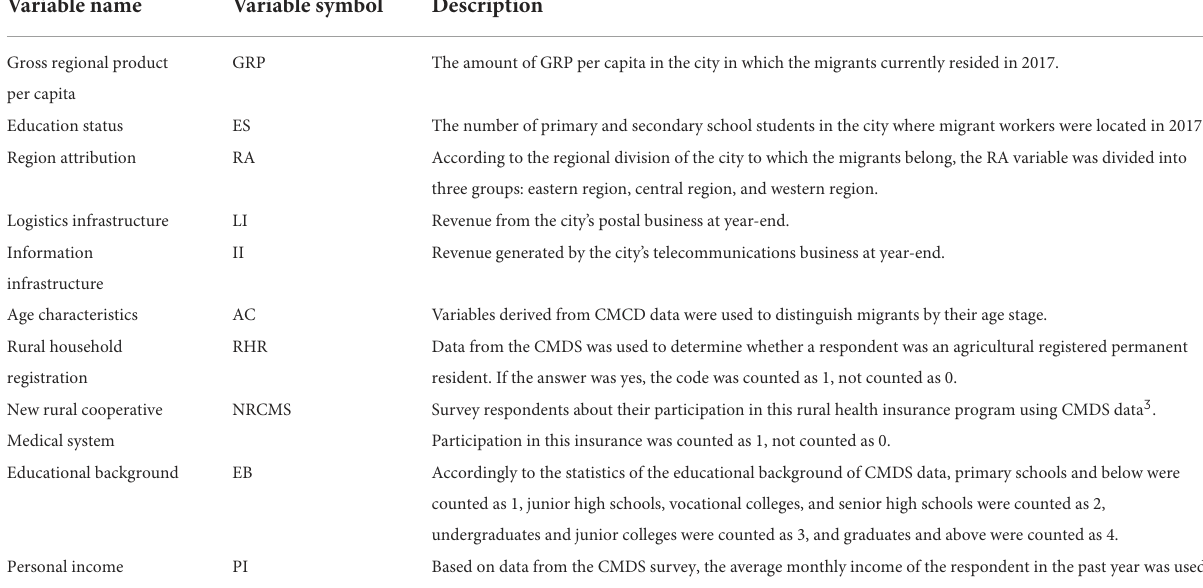
TABLE 1 Control variable